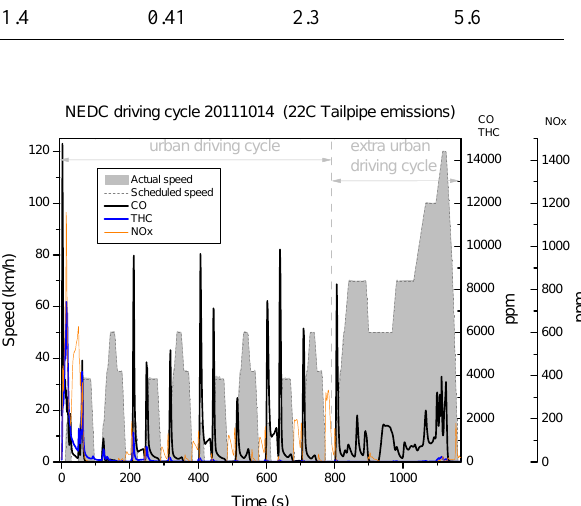
Fig. 3. Vehicle speed during the New European Driving Cycle (NEDC, grey, left axis) and average exhaust concentrations of the regulated compounds carbon monoxide (CO, black) and total hy- drocarbon (THC, blue), both on the first right axis, and oxides of nitrogen (NO x , orange) on the second right axis for Exp. 2 during the driving cycle. The NEDC is split into two phases representing urban driving and a second phase representing extra-urban driving.